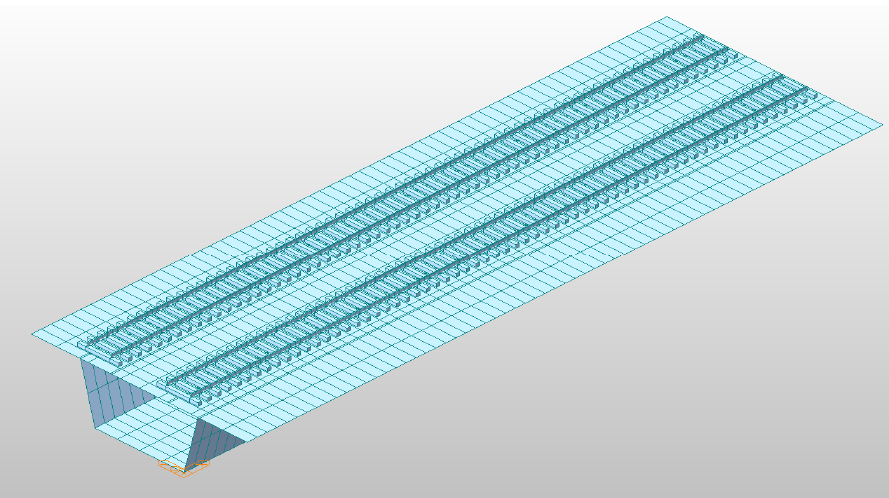
Figure 4. Three-dimensional analytical model (L = 10 m).